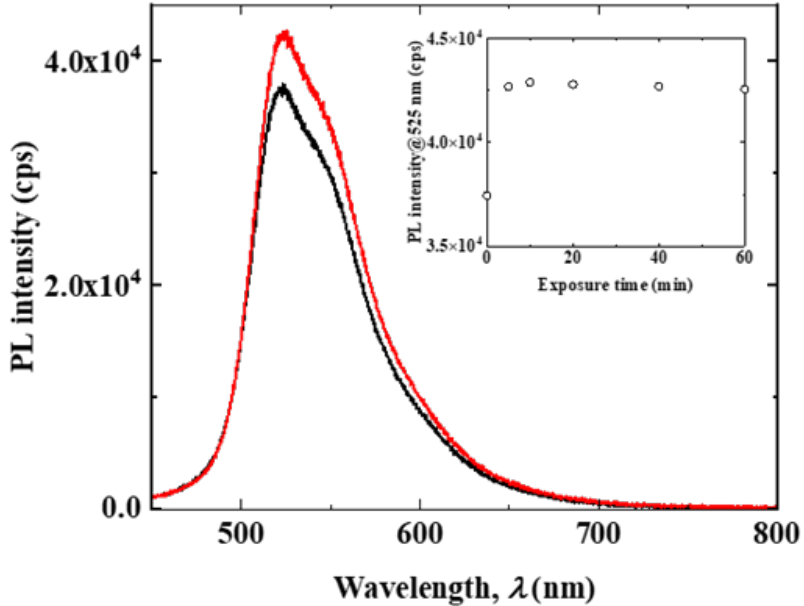
Figure 2. Photoluminescence spectra of layered double hydroxide (LDH)/anionic fluorescein dye (AFD)/1-butanesulfonate (C4S) hybrid powder under humid NH 3 gas flow condition (relative humidity (RH) = 60%, [NH 3 ] = 5.33 ppm) at room temperature. Black and red lines are before and after NH 3 exposure for 5 min. Inset is dependence of photoluminescence intensity, at 525 nm, on exposure time.